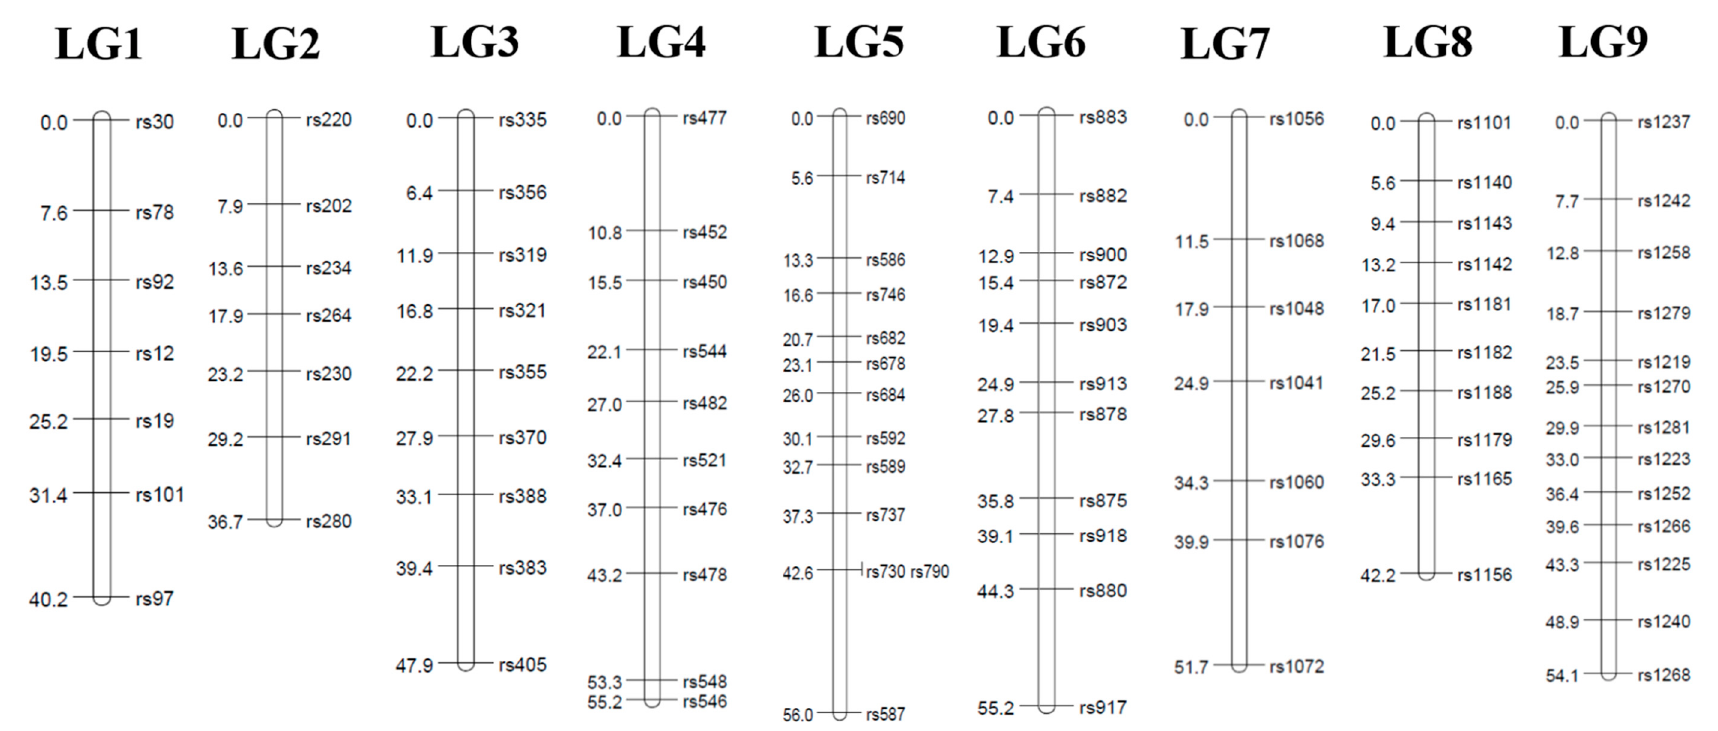
Figure 3. Genetic linkage map of GX50 constructed from an outbred population between GX50 and GX71. The map was constructed from 87 discovered SNPs and genotyped using GBS, including SNPs from all three pseudo-testcross segregation types.